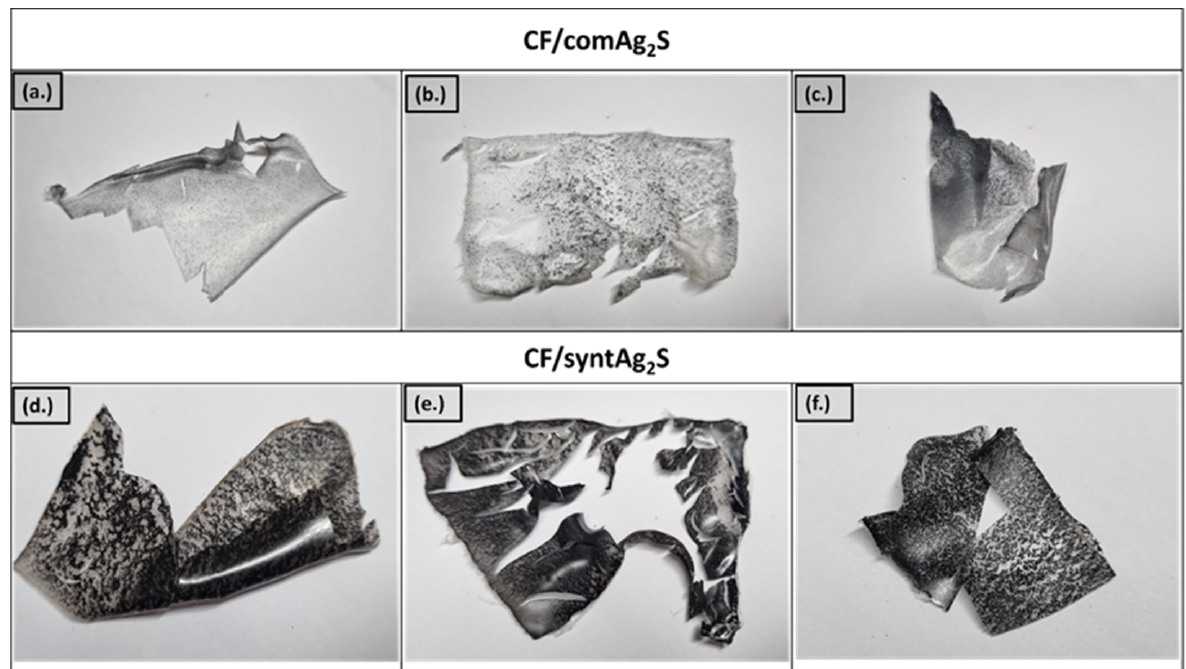
Figure 3. Prepared cellulose films: ( a ) CF/comAg 2 S1, ( b ) CF/comAg 2 S2, ( c ) CF/comAg 2 S3, ( d ) CF/syntAg 2 S1, ( e ) CF/syntAg 2 S2, and ( f ) CF/syntAg 2 S3.